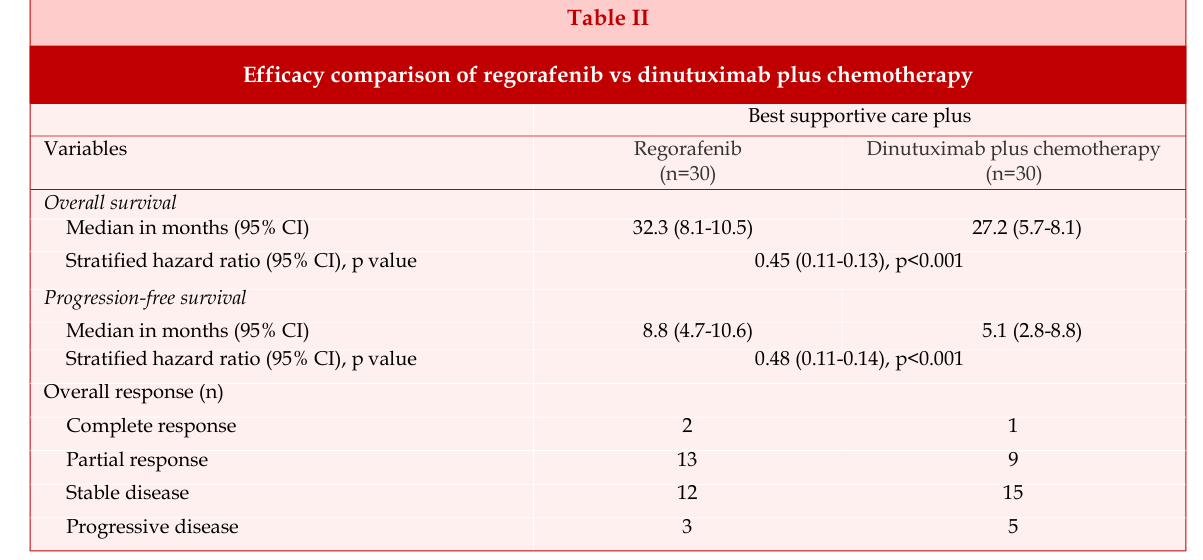
Best supportive care